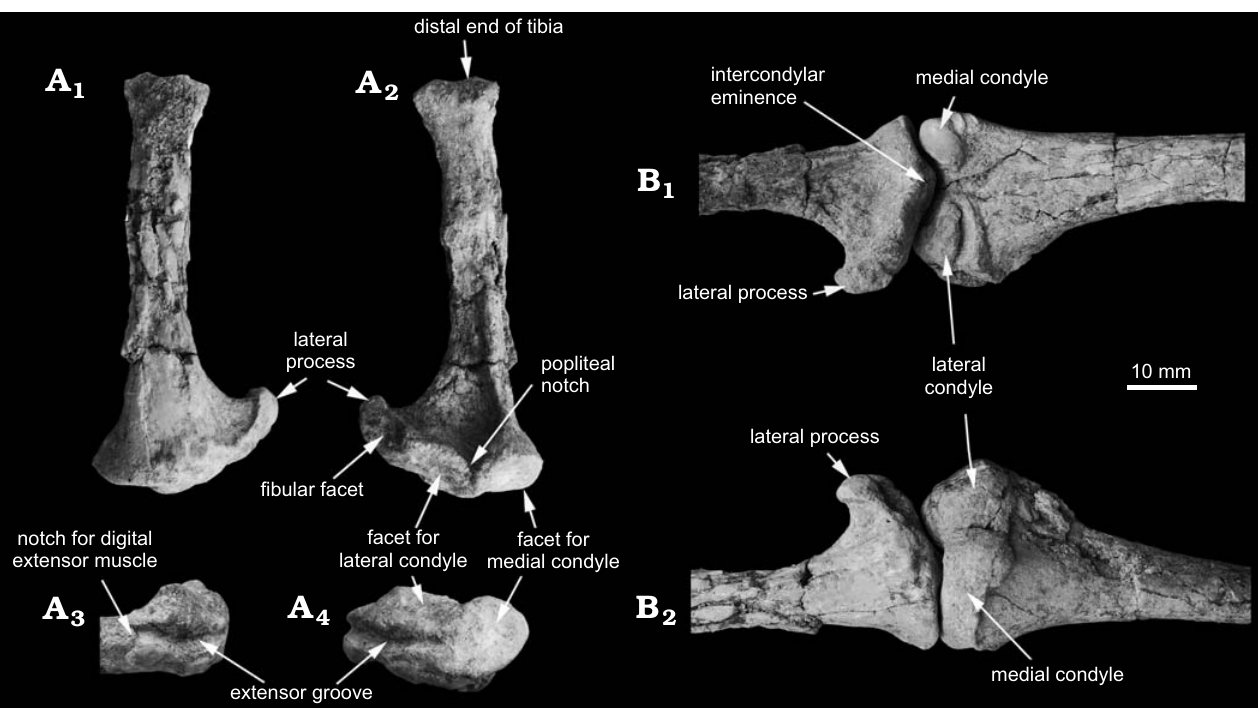
Fig. 13. The tibia of multituberculate mammal Sphenopsalis nobilis Matthew, Granger, and Simpson, 1928 (IVPP V19030) from the upper Paleocene Nomogen beds at the Erden (Urtyn) Obo locality, Inner Mongolia, China . A . Right tibia in anterior (A 1 ) and posterior (A 2 ) views, proximal end in lateral (A 3 ) and proximal (A 4 ) views. B . Femur-tibia articulation in posterior (B 1 ) and anterior (B 2 )